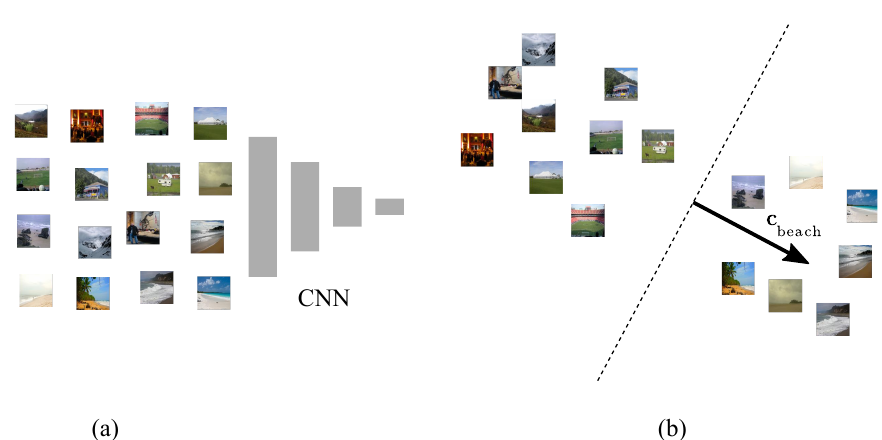
Figure 3. Concept Activation Vectors (CAV): Given a set of positive and negative images for a concept, in this case, beach ( a ), the activation vectors at layer l are computed for each of them and a linear classifier is used to discriminate between the two sets ( b ). The CAV for concept beach is the vector orthogonal to the decision hyperplane (dashed